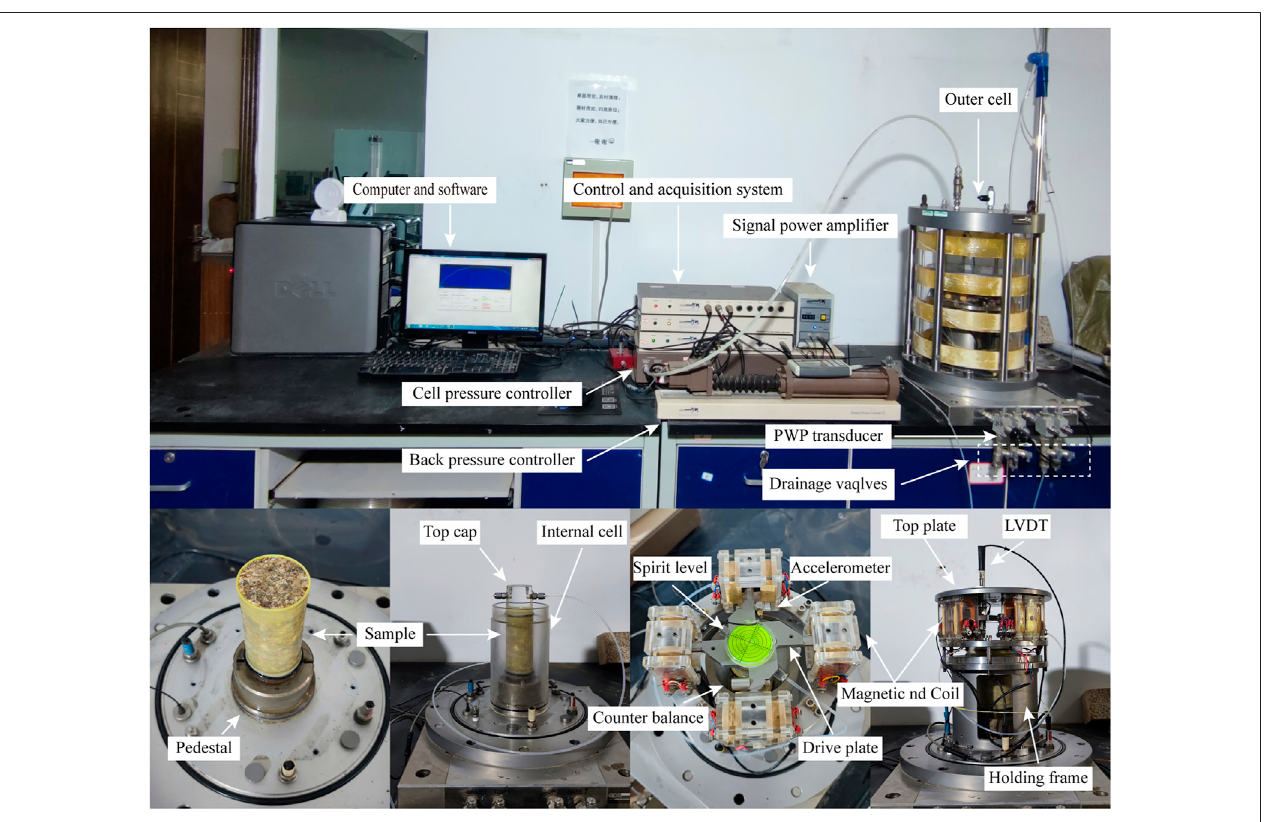
FIGURE 6 | Schematic view of the resonant-column apparatus and the experimental setup.